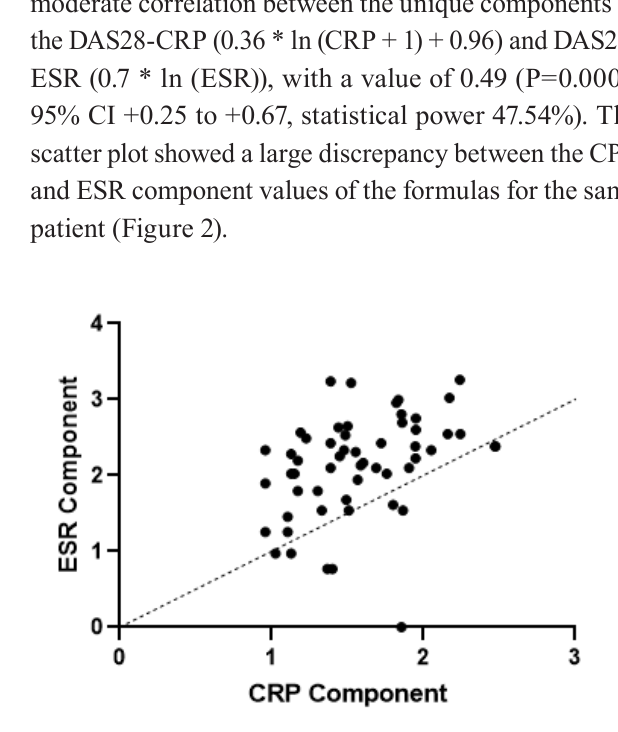
FIGURE 2 - The ESR components of the DAS28-ESR (x-axis) opposed to the CRP components of the DAS28-CRP (y-axis). Each point corresponds to a single patient. The diagonal line indicates agreement between the